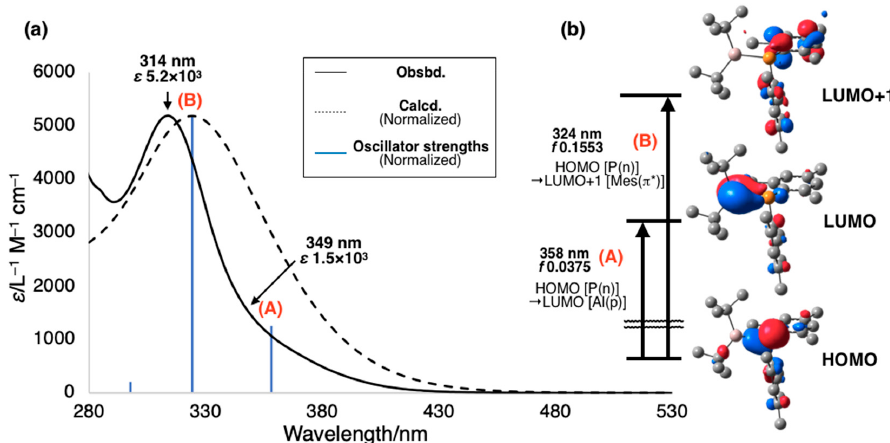
Figure 3. ( a ) Observed (in hexane at 298 K) and simulated (derived from TD-DFT calculations at the B3LYP-D3 / 6-311 + G(d,p) // B3LYP-D3 / 6-31G(d) level of theory) UV–Vis spectrum for 1 , whereby the calculated oscillator strengths are shown as blue vertical lines. ( b ) Electronic transitions corresponding to the absorptions (A) and (B). Hydrogen atoms are omitted for clarity. Color code: Al, pink; C, light gray; P,